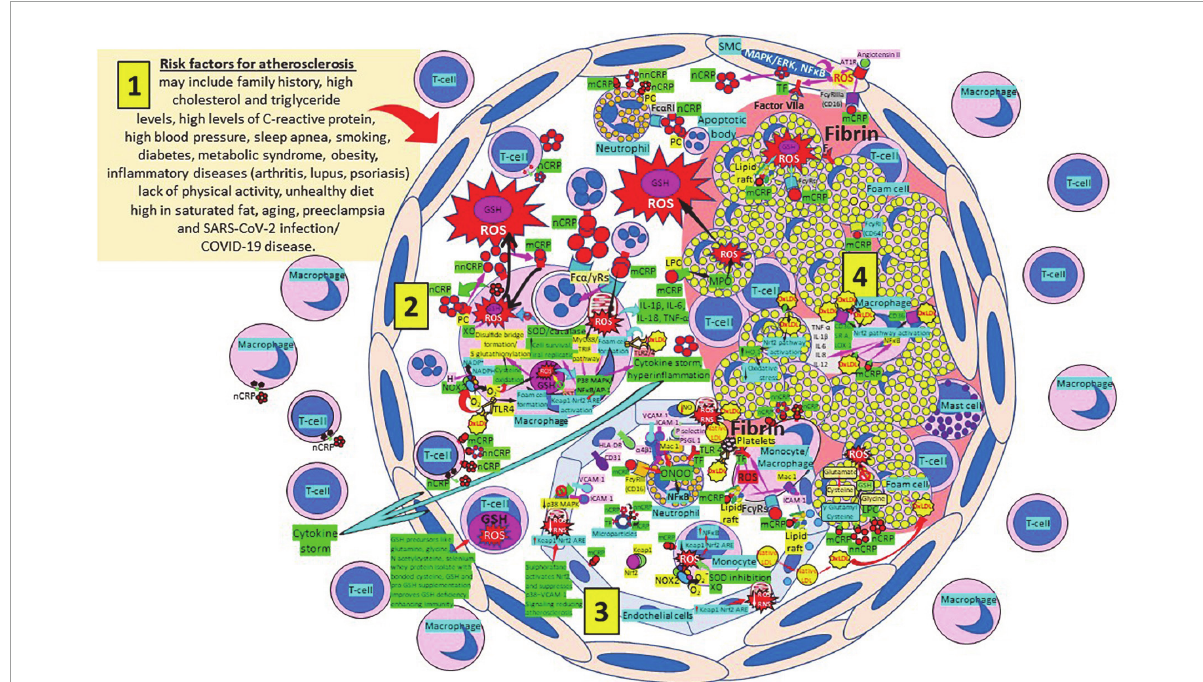
FIGURE7 Oxidative stress, reduced glutathione (GSH) and atherosclerosis. (1) Risk factors for atherosclerosis. (2) Atherosclerosis risk factors facilitate oxidative stress and inflammation in the arterial intima. Native C-reactive protein (nCRP), a pattern recognition receptor produced in the liver, macrophages, lymphocytes, smooth muscle cells (SMC), and other cells, promotes inflammation through monomeric CRP (mCRP) enhancing intimal oxidative stress. Oxidized (ox) LDL binds macrophage toll-like receptor (TLR) 4 and facilitates nicotinamide adenine dinucleotide phosphate (NADP)H oxidase 2 (Nox2) activity and superoxide (O 2 − ) production causing cysteine oxidation, disulfide bridge formation and S-glutathionylation. Xanthine oxidase (XO) and inhibition of superoxide dismutase (SOD)/catalase further facilitate O 2 − cellular activity. OxLDL bound to TLRs 2 and 4 promotes foam cell formation and activates transcription factors like nuclear factor (NF)- κ B facilitating cytokine storm and hyperinflammation. Excessive mitochondrial reactive oxygen species (ROS) generation further enhances cytokine production. CRP (nCRP, mCRP) can facilitate macrophage and neutrophil uptake of apoptotic cells through Fc γ and Fc α receptors, respectively (FcRs). Oxidative stress also activates the Kelch-like ECH-associated protein 1 (Keap1)-Nuclear factor erythroid 2-related factor 2 (Nrf2)-antioxidant response element (ARE) redox regulator pathway in monocytes [see (3) and macrophages (2)], releasing Nrf2 to regulate the expression of genes that control antioxidant enzymes like glutathione S-transferase (GST), facilitating glutathione (GSH) activity. Macrophages, T-lymphocytes, neutrophils